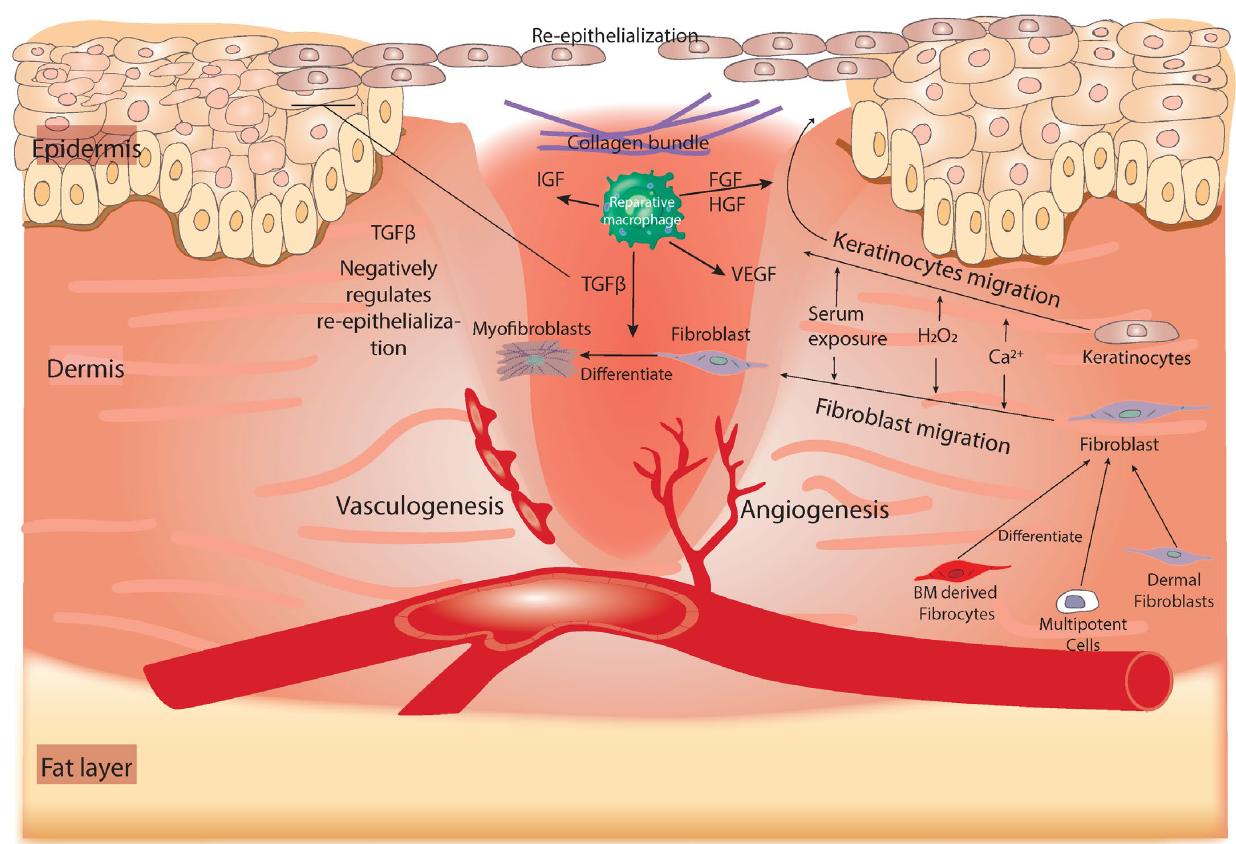
Figure 3. Summary of the tissue-regeneration phase of healing. In this phase, re-epithelialization and the formation of collagen-based ECM occur. Keratinocytes and fibroblasts can migrate to the wound in response to releasing H 2 O 2 , exposed Ca2+, and serum from damaged tissue. Fibroblasts are provided to the injured tissue either from the healthy dermis, BM-derived fibrocytes, or multipotent precursor cells. Both fibrocytes and multipotent cells can differentiate into fibroblasts before they are recruited to the wound. Reparative macrophages (green-colored in the wound) play an essential role in this phase by producing several growth factors, including FGF, TGF- β, IGF, and VEGF. TGF- β promotes the differentiation of fibroblasts into myofibroblasts, a type of contractile cell that can re-approximate the wound edges. Additionally, it can negatively regulate the re-epithelialization process. FGF and HGF are associated with keratinocyte migration to the wound edge to perform re-epithelialization. BM, bone marrow; FGF, fibroblast growth factor; IGF, insulin-like growth factor; PMN, polymorphonuclear neutrophil; TGF- β , transforming growth factor beta; VEGF, vascular endothelial growth factor; FGF, fibroblast growth factor; HGF, hepatocytes growth